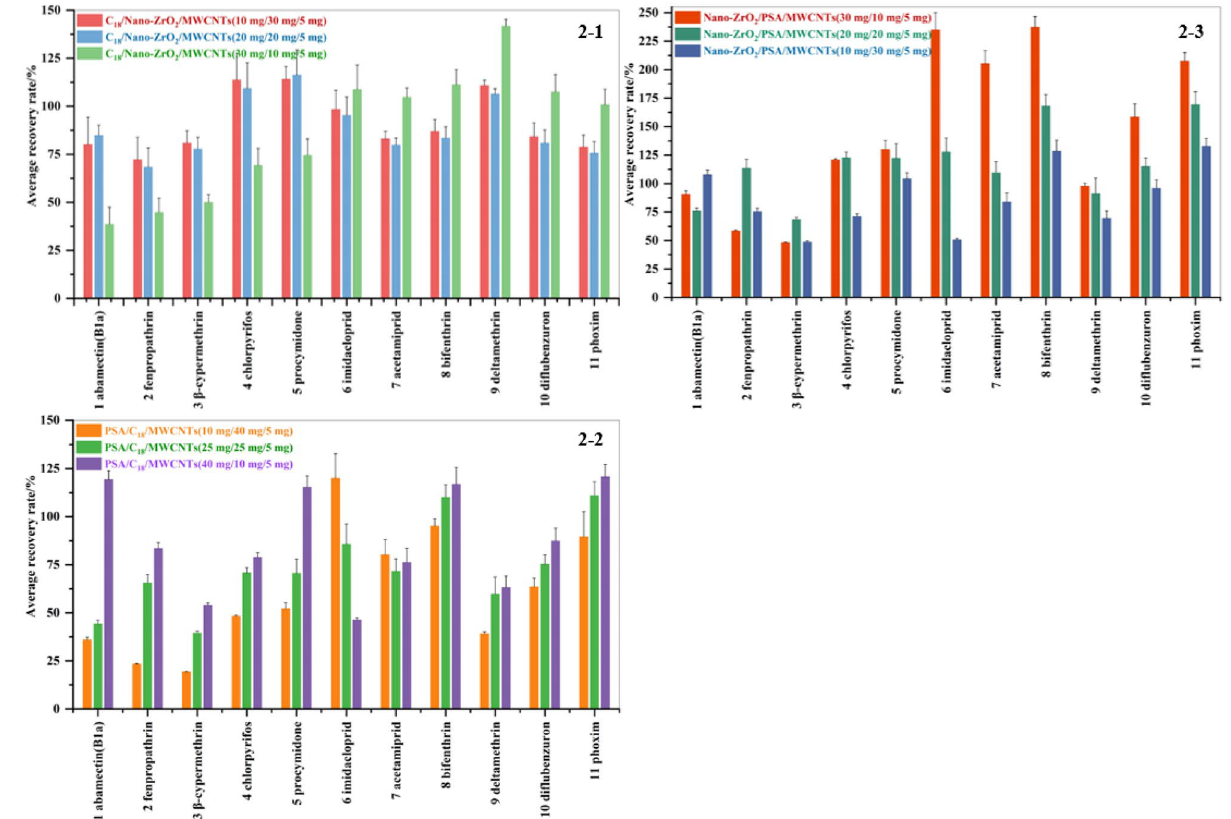
Figure 2. The recoveries of 11 pesticides in apricot matrix under different scavenger combinations (2–1 C 18 /